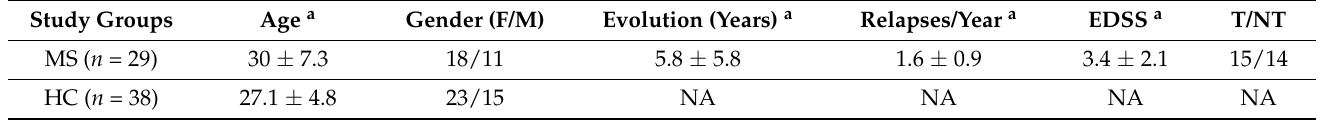
Table 1. Clinical and demographic data of MS patients and